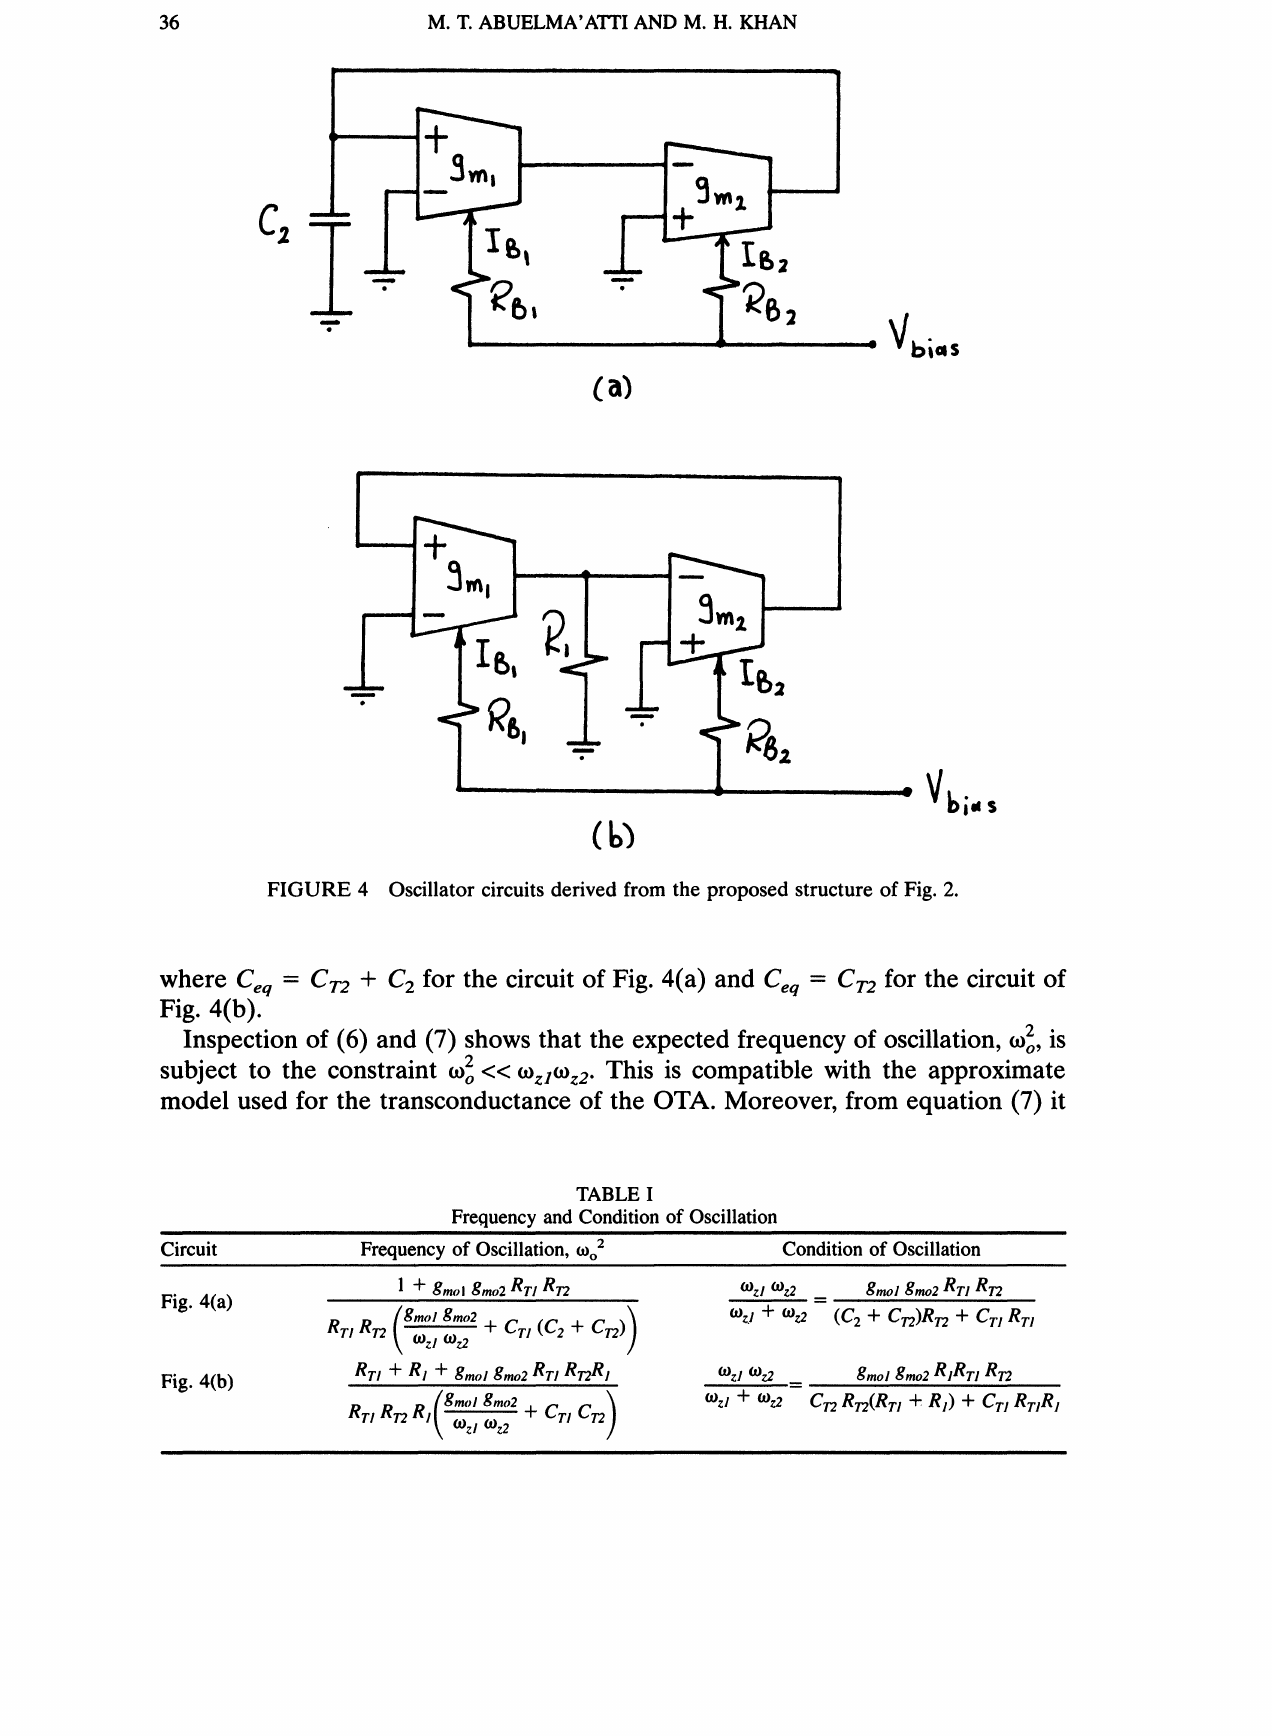
FIGURE 4 Oscillator circuits derived from the proposed structure of Fig.